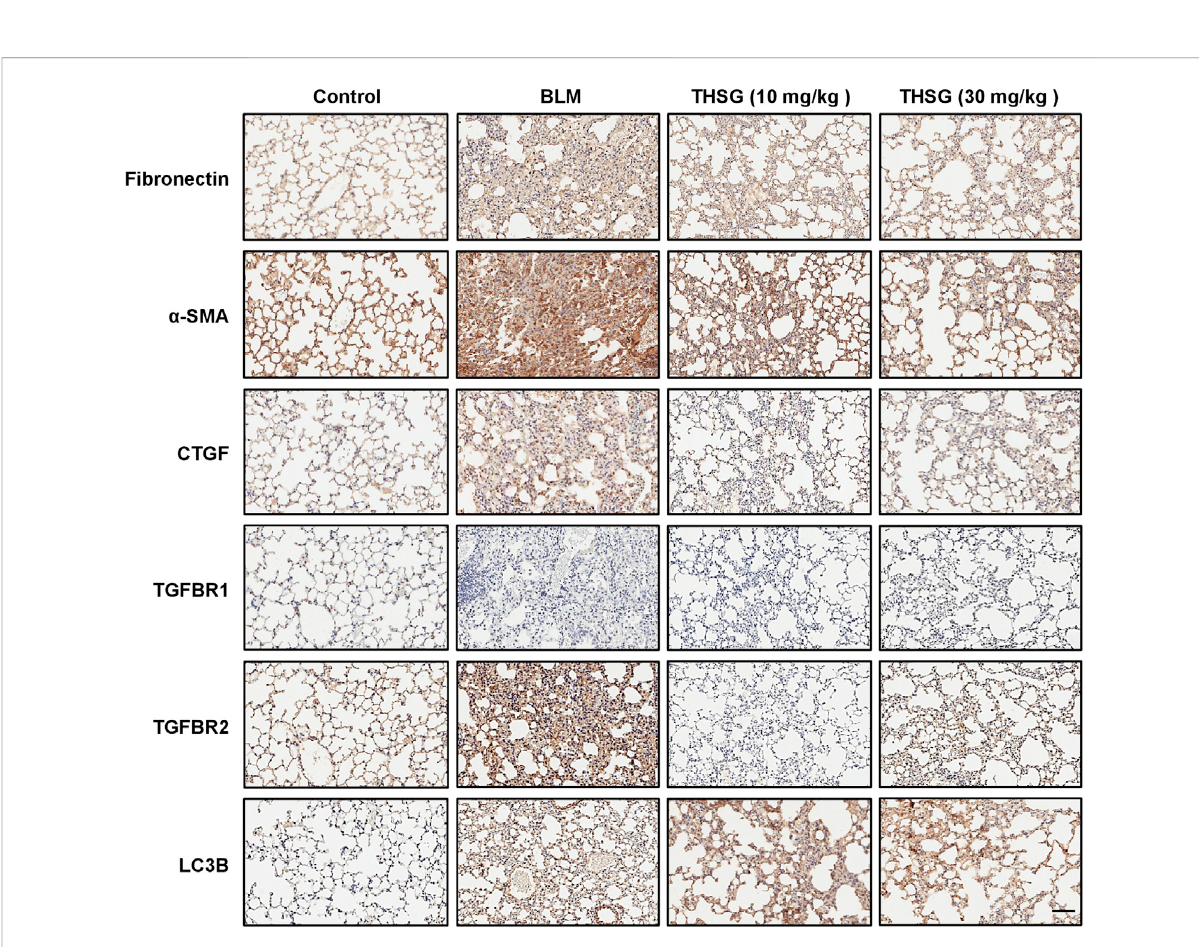
FIGURE 7 Effect of THSG on fi bronectin, α -SMA, CTGF, TGFBR1, TGFBR2, and LC3B expression in the lung tissues of BLM-stimulated mice on day 21. Representative photographs of immunohistochemical staining for fi bronectin, α -SMA, CTGF, TGFBR1, TGFBR2, and LC3B in the lung sections of mice from different experimental groups. Scale bar: 100 μ